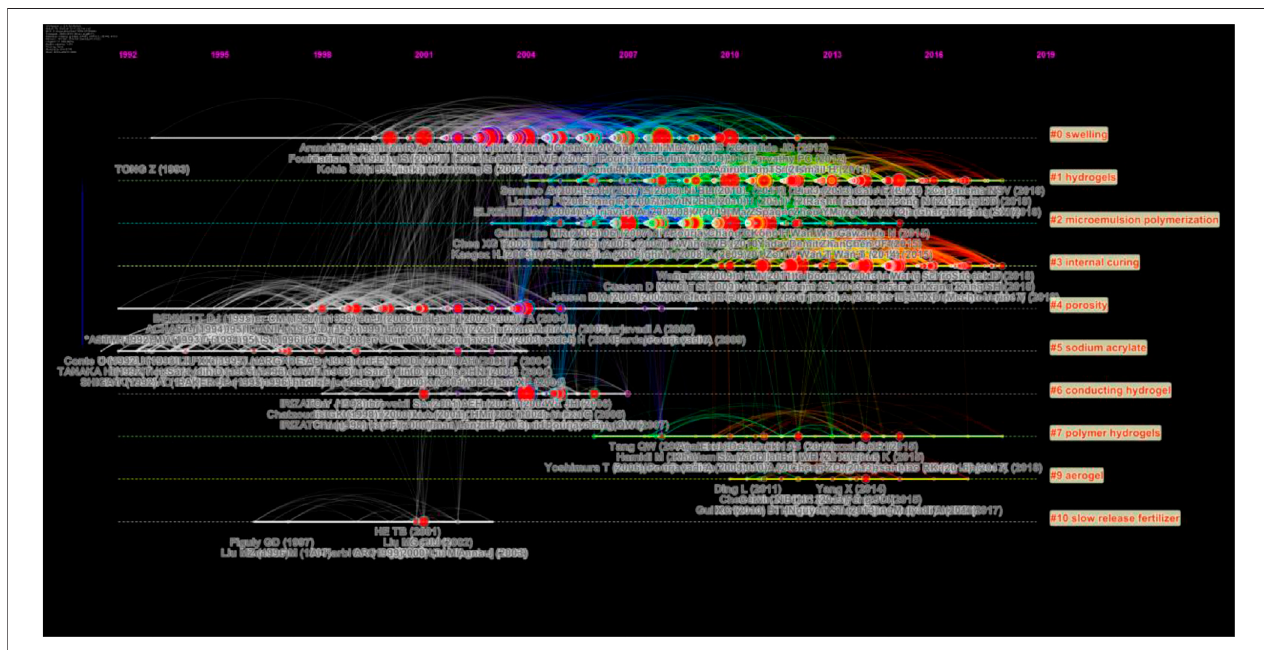
FIGURE 5 | Timeline visualization of superabsorbent research of the ten major clusters from CiteSpace.